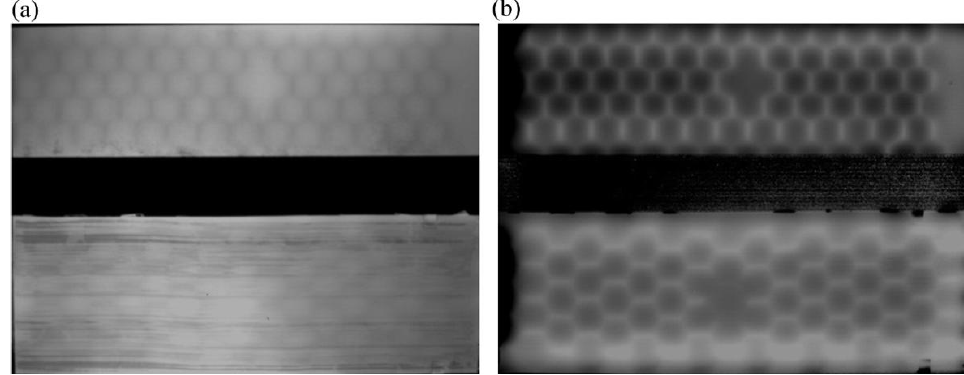
Figure 7. Lock-in thermography testing of a titanium alloy honeycomb sandwich structure with disbond, with permission from 74.